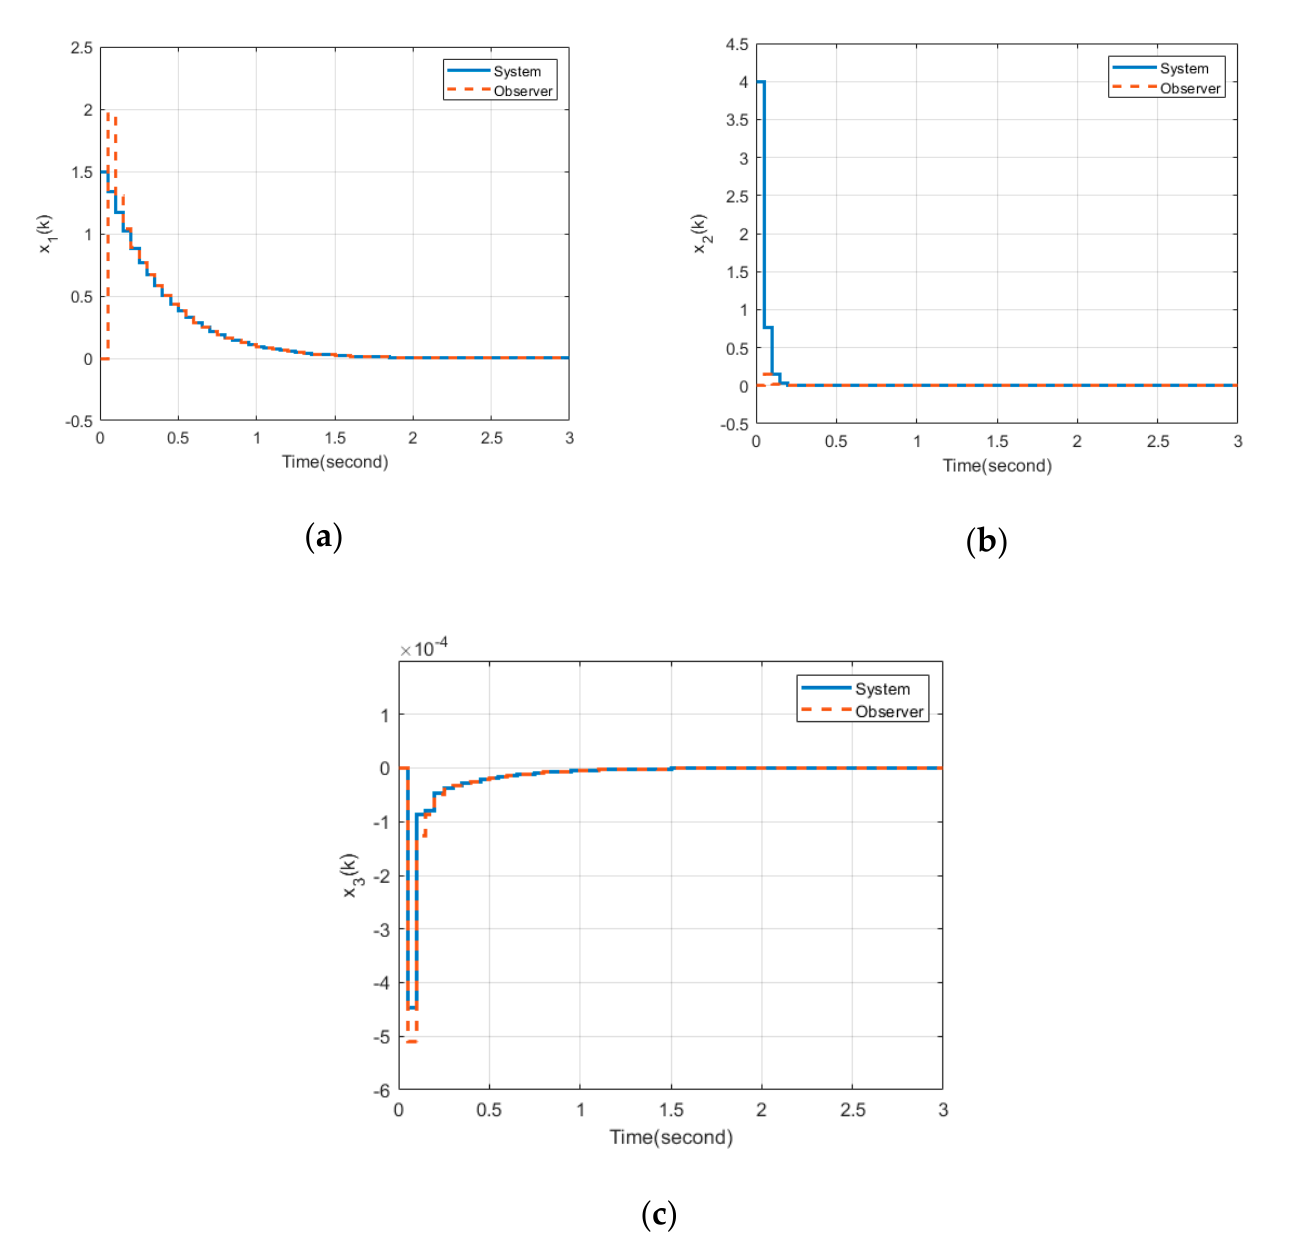
Figure 2. ( a ) The state and observer responses of x 1 ( k ) ; ( b ) The state and observer responses of x 2 ( k ) ; ( c ) The state and observer responses of x 3 ( k ) ;